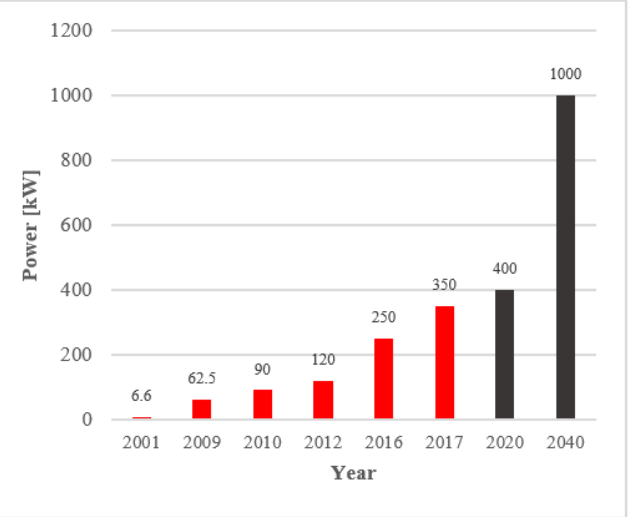
Figure 1. Increase peak power versus year for DC fast charger (red color for current power and gray color for predicted power) [13].